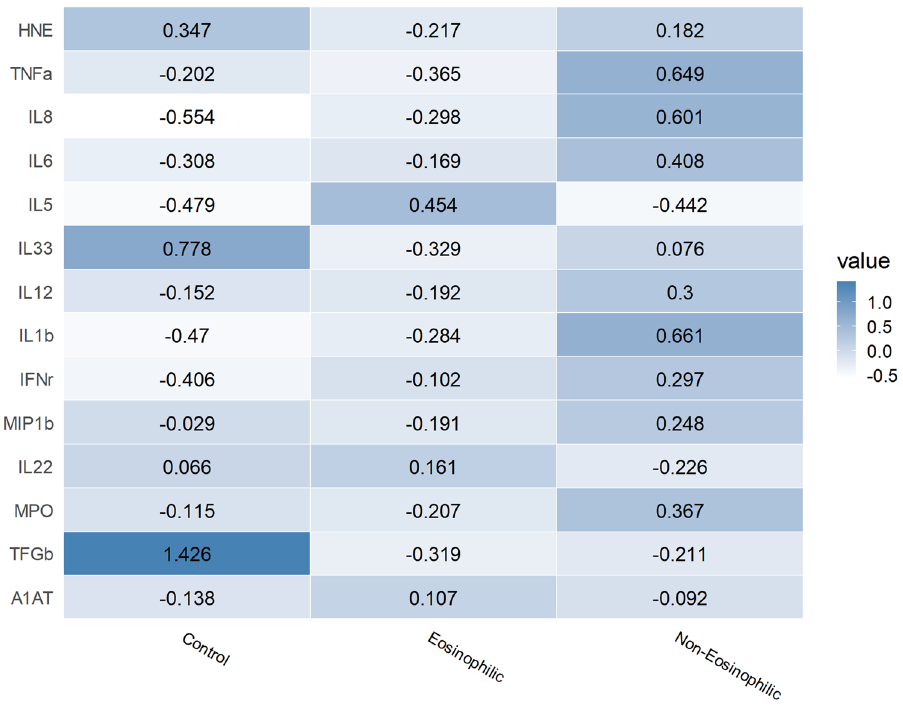
Figure 2. Heatmap of protein concentrations among patient classes. The color bar presents Z-scores of tissue concentration for each measured cytokine.